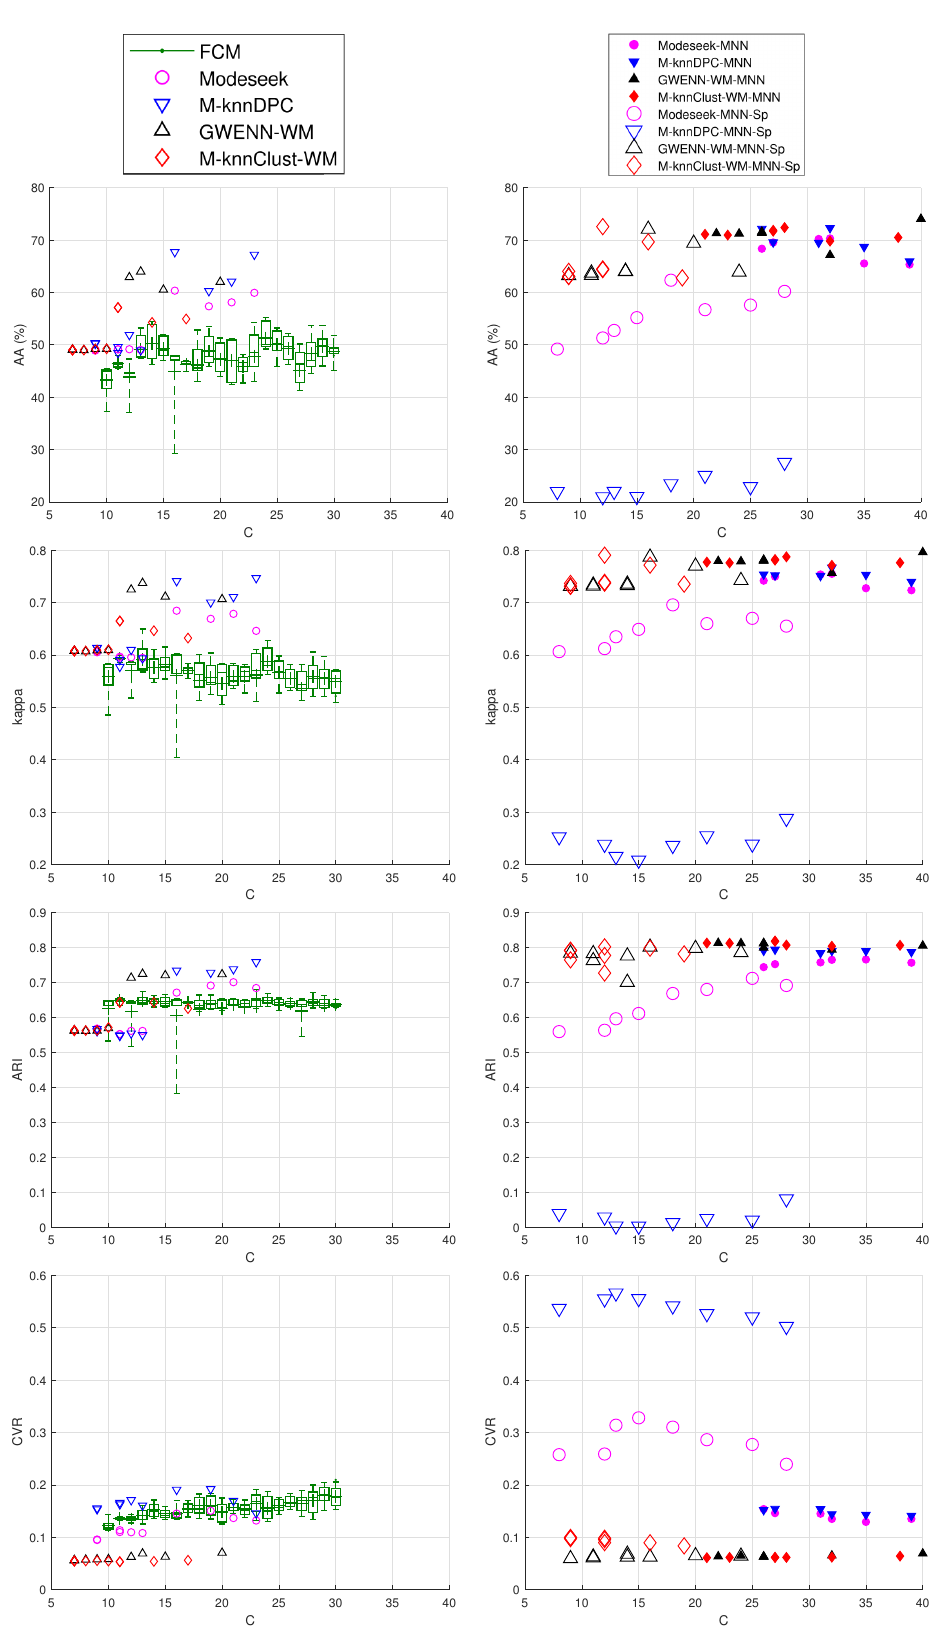
Figure 11. Clustering results of Hekla HSI as a function of the number of clusters. Left column: FCM and baseline nearest-neighbor methods; right column: HSI-improved nearest-neighbor methods. From top to bottom: average accuracy; kappa index; adjusted Rand index; consistency violation